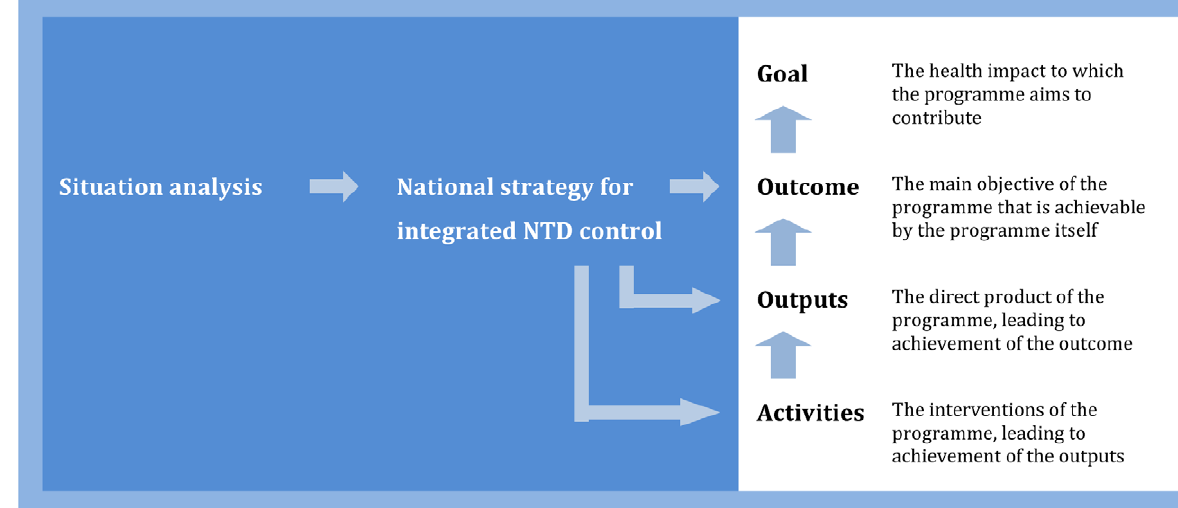
Figure 2. Development of a programme framework. Modified from [47].